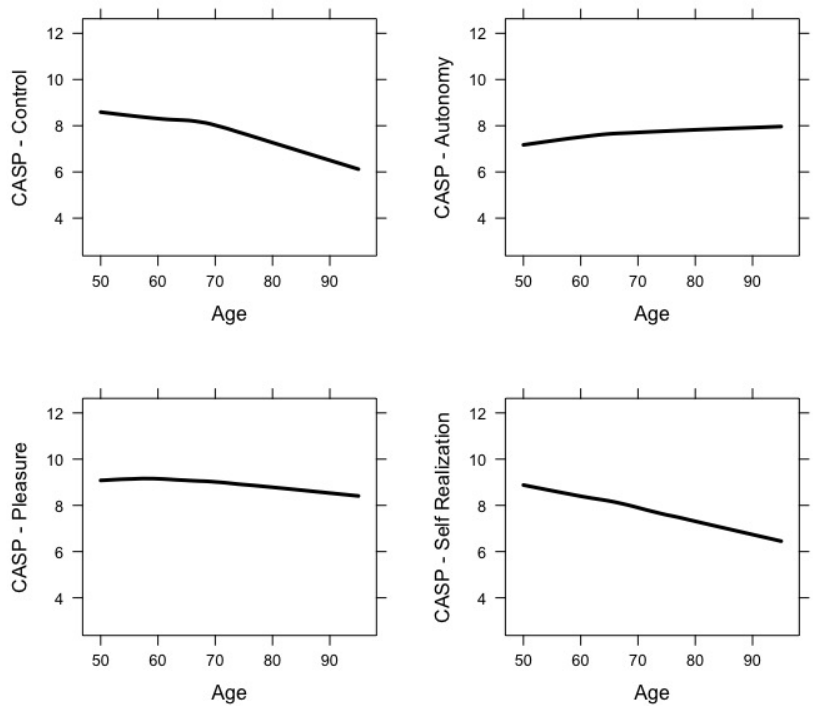
Figure 2. Domain-specific mean CASP-12 trajectories across age.